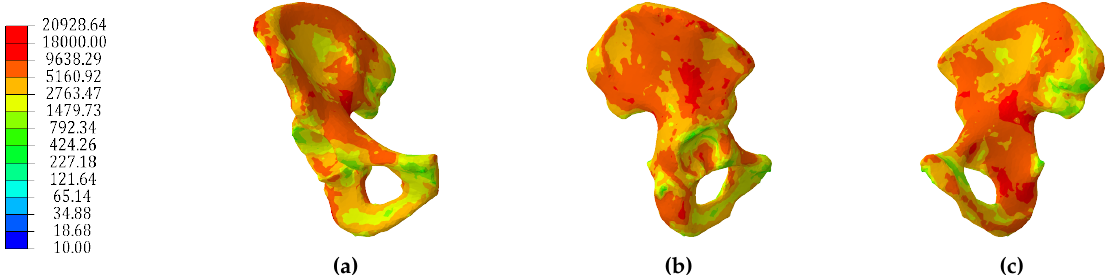
Figure 2. Distribution of Young’s modulus (MPa) across the CT scan derived model - shown for ( a ) frontal, ( b ) lateral, and ( c ) medial